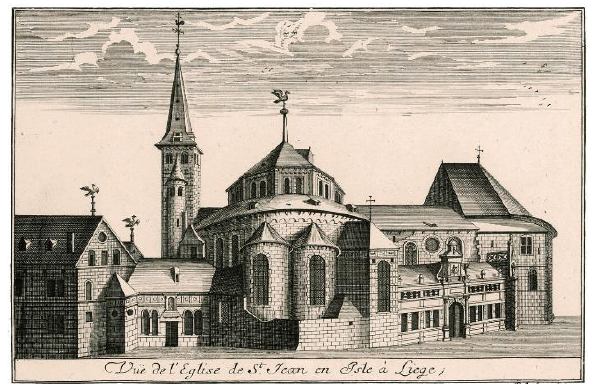
Figure 4. Engraving of Saint-John collegiate church, in 1738 by Remacle Le Loup. Source: Chokier Website: www.chokier.com